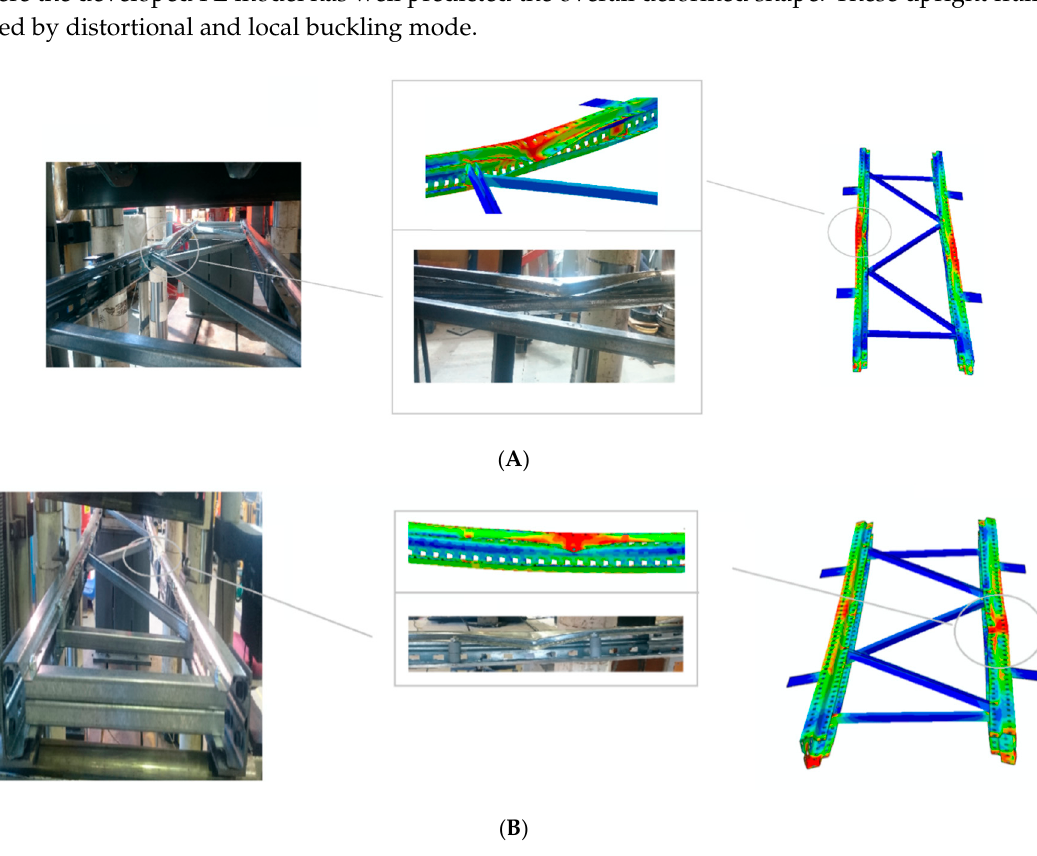
Figure 30. Comparison of failure mode: ( A ) non-reinforced upright type; ( B ) 300 mm reinforced upright type.